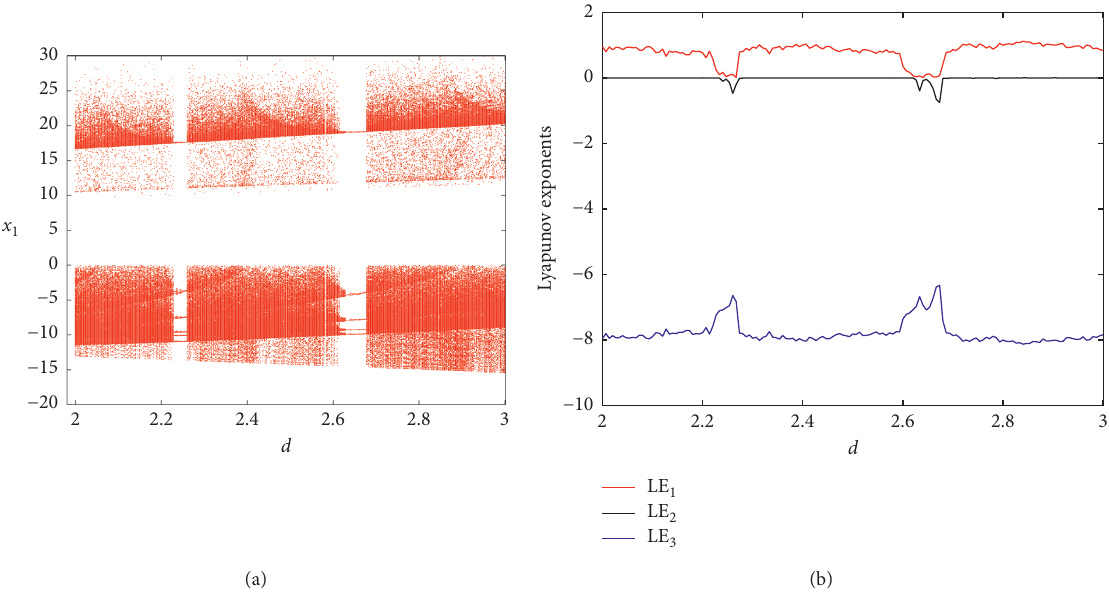
Figure 7: (a) Bifurcation diagram and (b) finite time Lyapunov exponent spectrum versus d